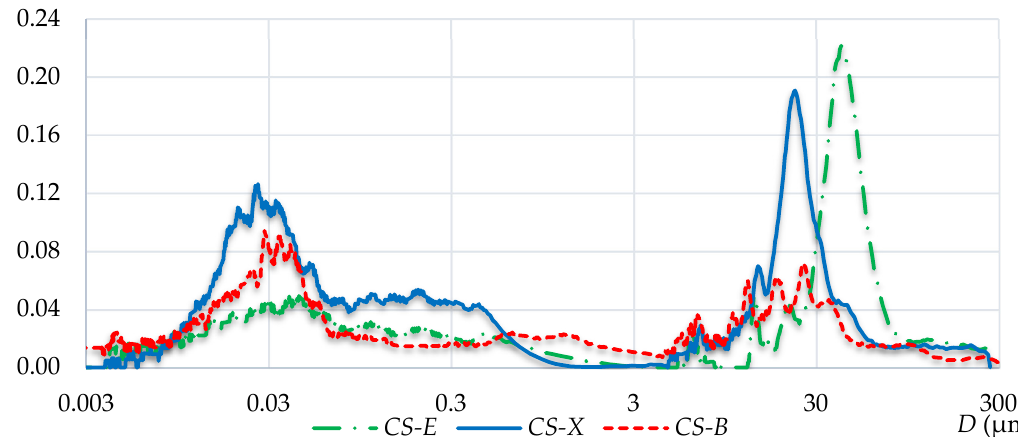
ff erential pore distribution curves of the three tested Figure 6. Differential pore distribution curves of the three tested silicates. Figure 6. Di Figure 6. Differential pore distribution curves of the three tested silicates.